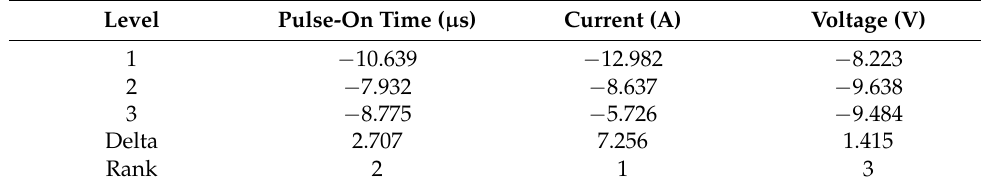
Table 11. Ranking of input